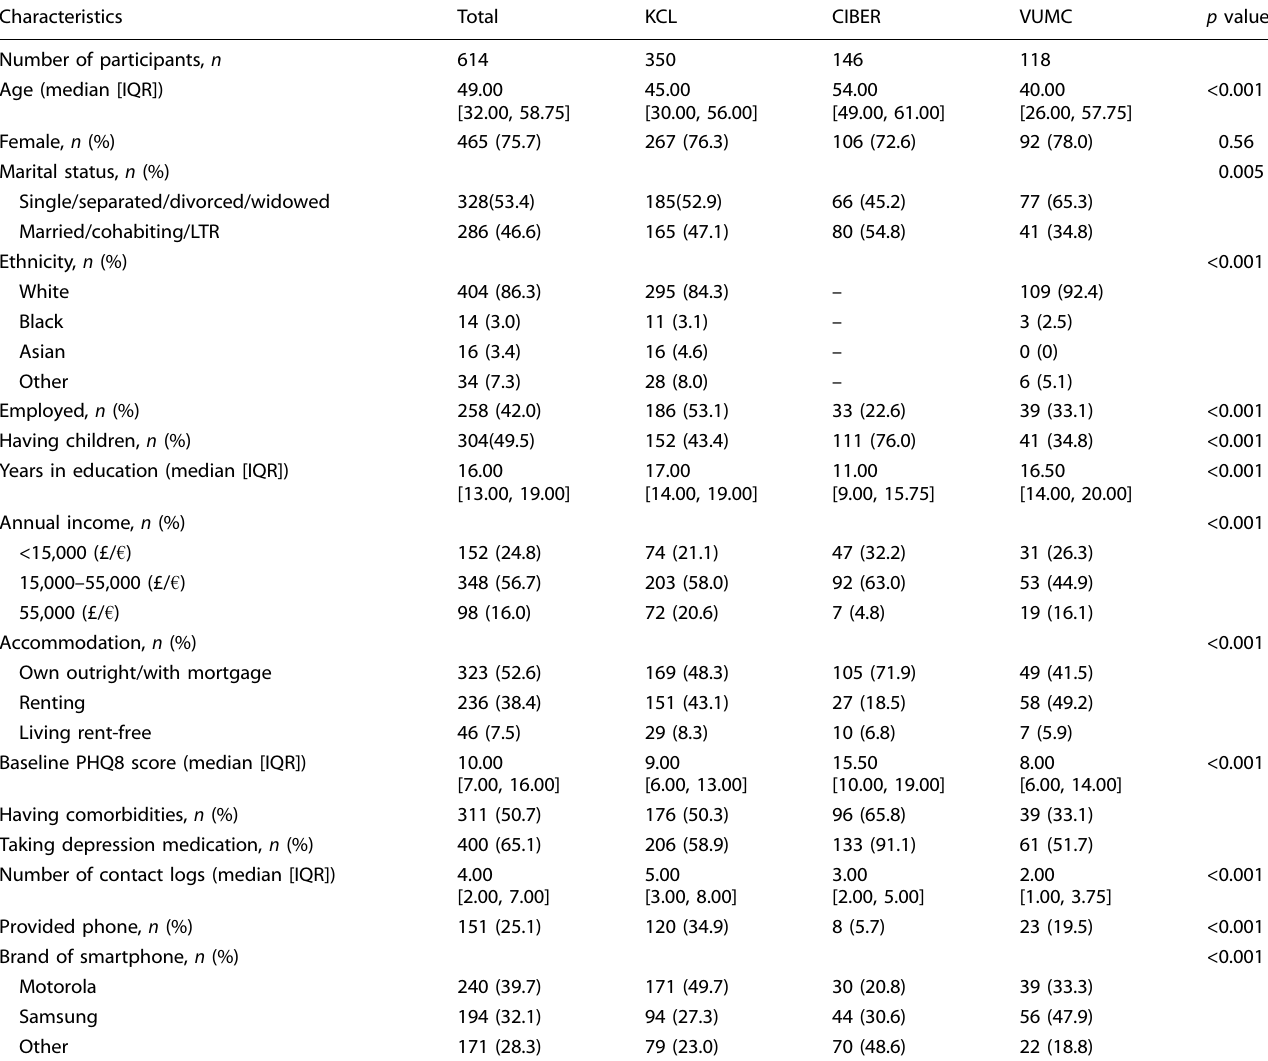
Table 1. A summary of characteristics of 614 participants in the RADAR-MDD study, with comparisons across the three study sites using Kruskal-Wallis tests.